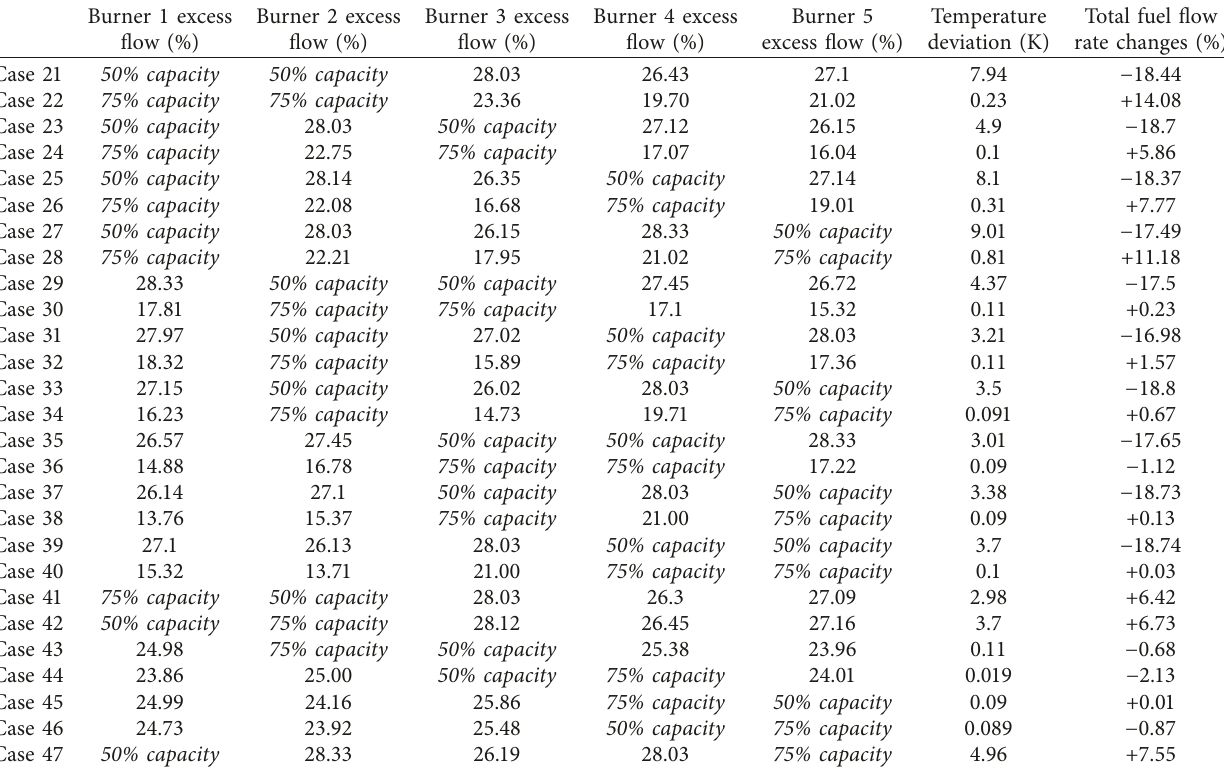
Table 4: Two-burner failure/firing capacity